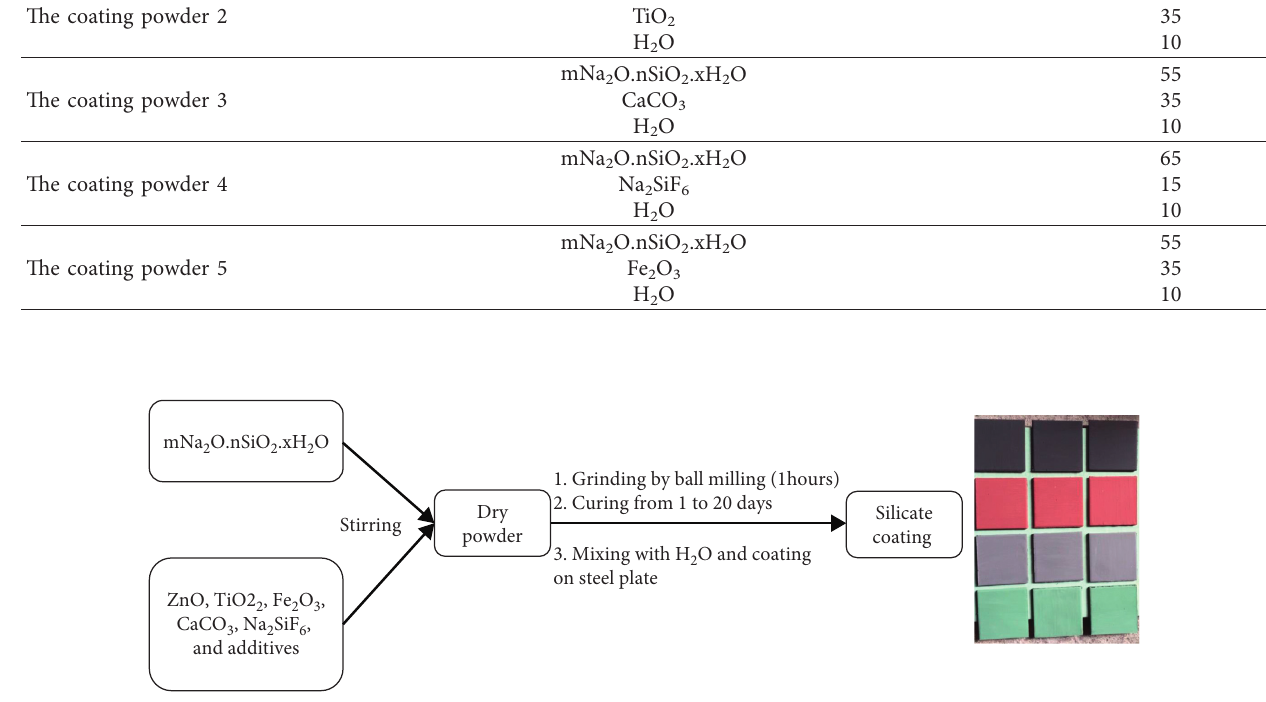
Silicate coating